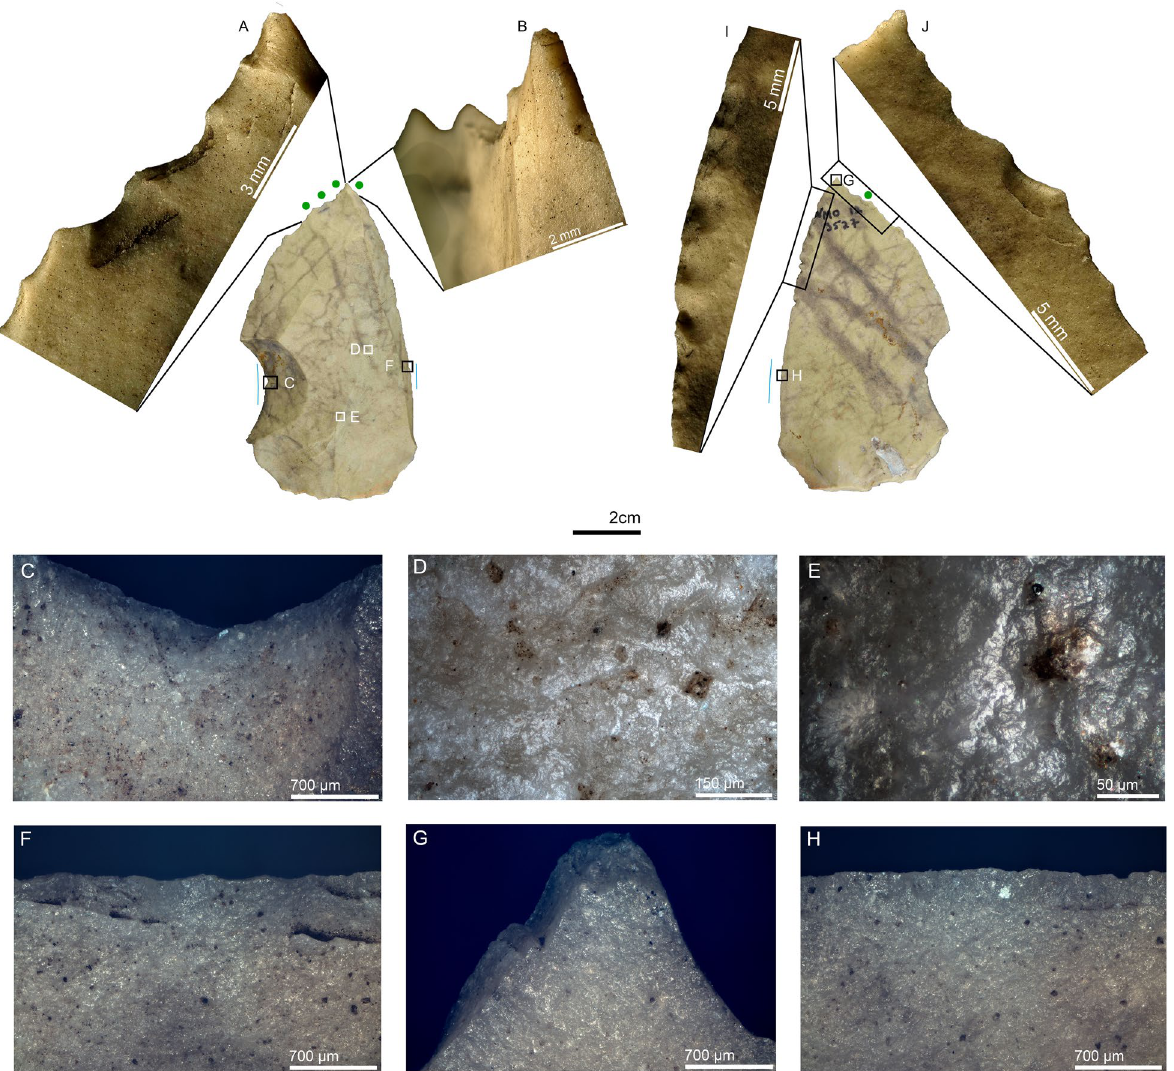
Figure 2. Retouched Levallois point NMO12 3527 interpreted as a projectile. ( A ) bending-initiated scars with step and feather terminations and edge crushing on the distal extremity of the dorsal left lateral edge, 35 ×; ( B ) burination that proceeds though a cascade of minor steps into a feather termination on the dorsal distal right edge, and tip crushing, 35 ×; ( C ) hafting bending-initiated scar with very shallow feather termination within the notch on the mesial dorsal left edge, 50 ×; ( D ) hafting polish on the dorsal right ridge, 200 ×; ( E ) hafting polish in a different point of the same ridge, 500 ×; ( F ) hafting scarring on the mesial dorsal right edge, 50 ×; ( G ) the burinations observed in B seen from the ventral distal right edge, and associated with tip crushing, 50 ×; ( H ) hafting scarring on the mesial ventral right edge, 50 ×; ( I ) retouch on the ventral distal right edge, 35 ×; ( J ) sliced and bending-initiated scars on the ventral distal left edge, 35 ×. *Blue solid lines indicate edge areas with hafting wear, and green dots represent edge areas with scarring. The same markers and color codes are valid for the rest of the Flakes, denticulates, and blades. Butchery is the most frequent activity observed on retouched (n = 3) and unre- touched flakes (n = 11) (Table 3). However, hafting traces were only observed on one unretouched flake (NMO08 2052). Use-wear traces observed on unretouched flakes indicate hide-cutting (n = 3) (Fig. S12), bone-scraping (n = 1), and wood-whittling (n = 1). Two Levallois flakes were found exhibiting use-wear characteristic of hide- cutting and wood-whittling (Fig. S13) and four denticulates were observed bearing traces typical of butchery (n = 1), hide-cutting (n = 2), and plant processing (n = 1). Use-wear on denticulates is located on elevated areas of topography between retouch removals (Fig. S14). Use-wear on retouched blades indicate their use as butcher- ing knives (n = 3), two of them while hafted. On one unretouched blade (NMO08 2122), well developed polish indicates whittling wood/plants (Fig. S15). In sum, animal carcass processing is represented by 81% of the NMO cutting elements (n = 43), while wood and plant processing are observed on only seven artifacts (13%). Within carcass processing, butchery activity